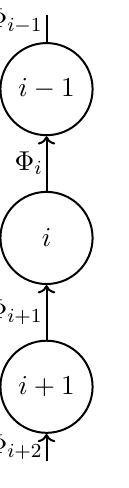
Figure 3. On the left we depict the quiver diagram for the free trinion theory of bifundamental chiral multiplets (arising as the orbifold of a bifundamental hypermultiplet). On the right we depict the associated sphere with one minimal puncture and two maximal punctures s l, + fugacities z and z label the global symmetry groups associated with the two maximal punctures). l r